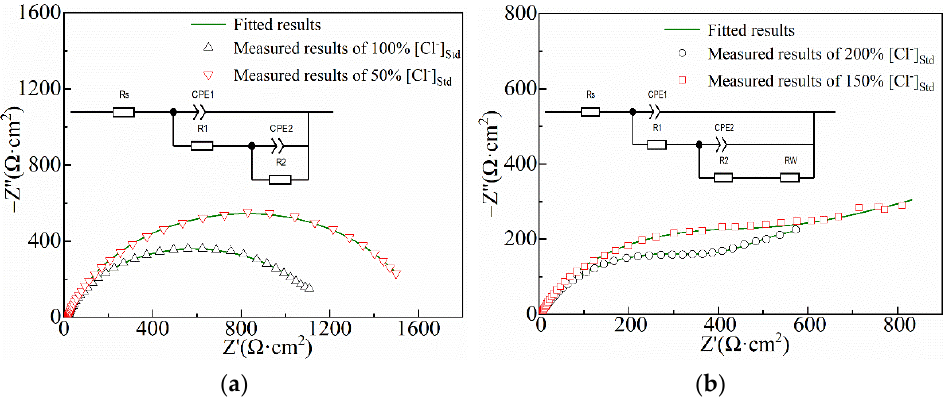
Figure 2. Electrochemical impedance spectroscopy at different Cl − concentrations: ( a ) low Cl − con- centrations; ( b ) high Cl − concentrations .